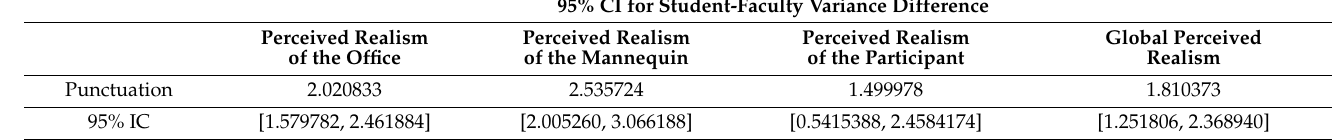
Table 5. Confidence intervals and individual estimates of the difference in mean student and faculty